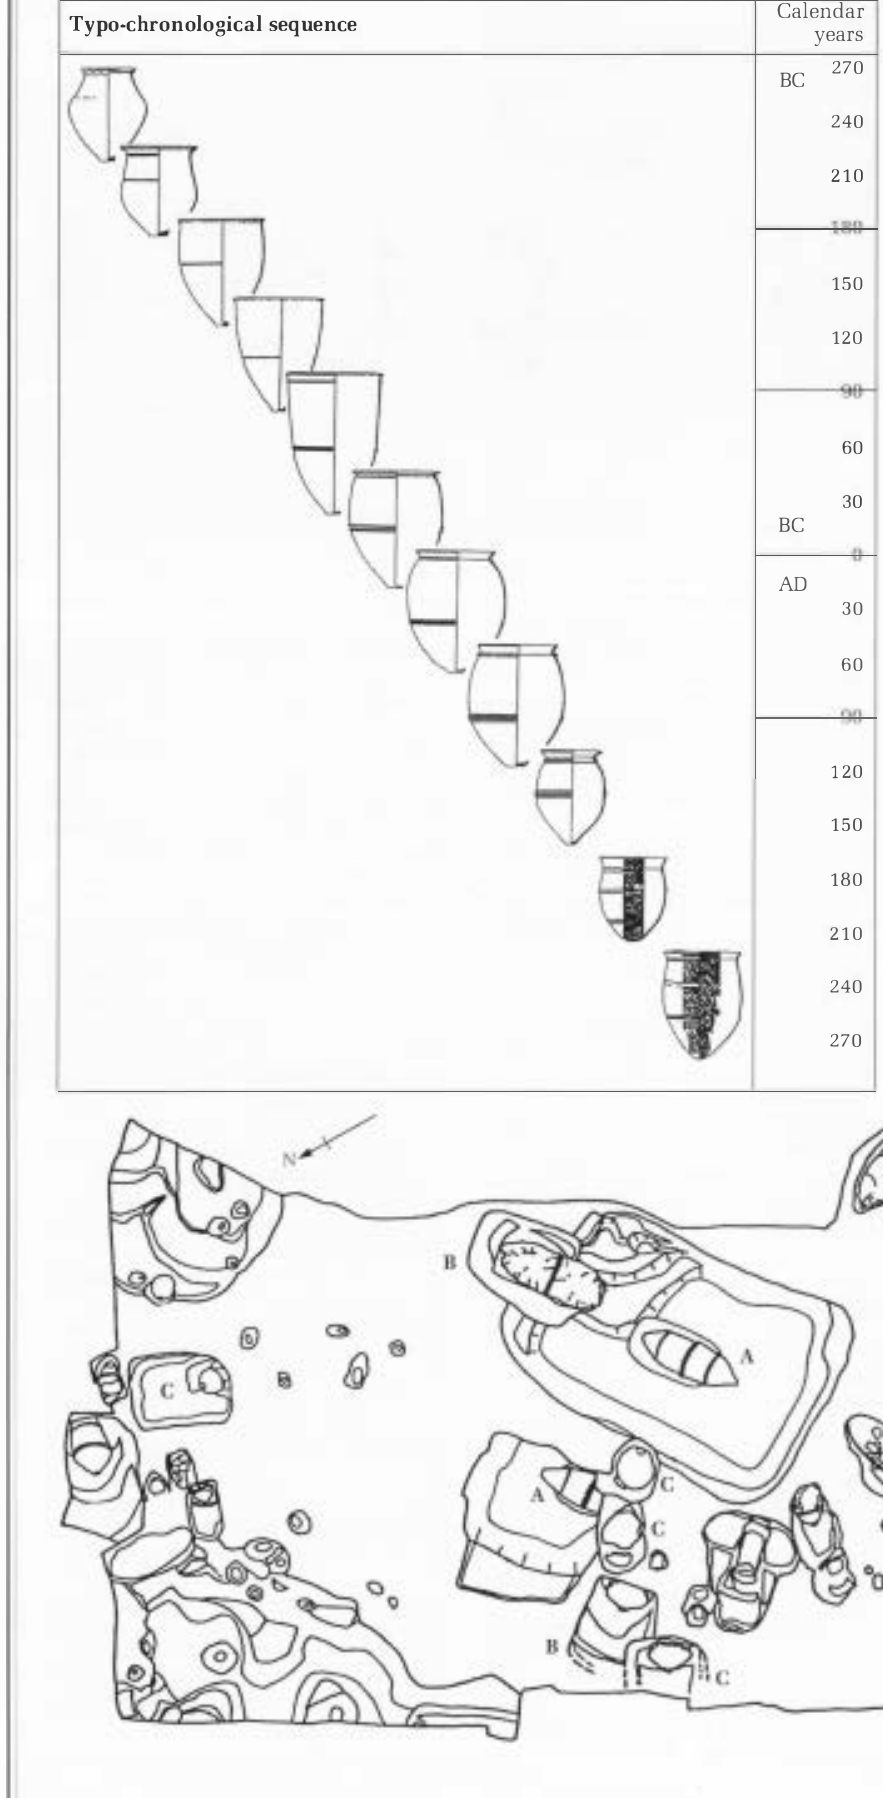
Figure 2 Typo-chronology of burial jars. The calendric dates given are based on a combination of evidence from Chinese documents and dateable artefacts of Chi­ nese origin found in the